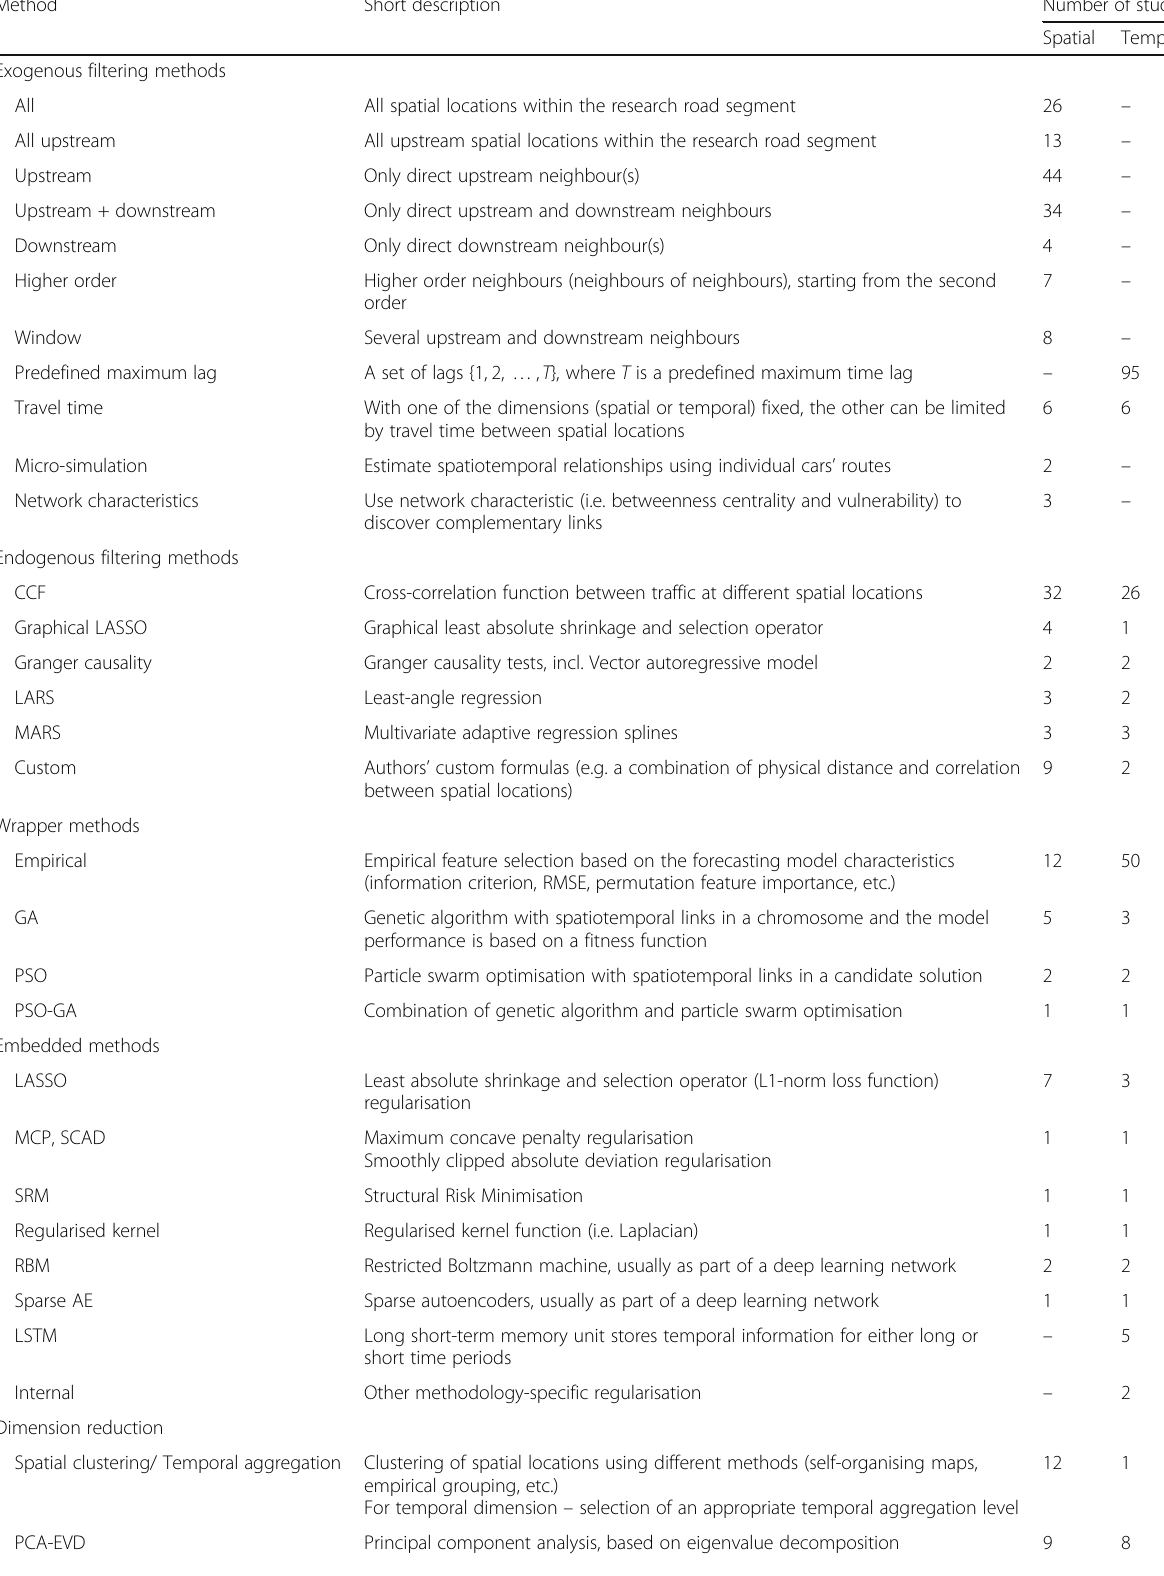
Table 1 Spatiotemporal FSE